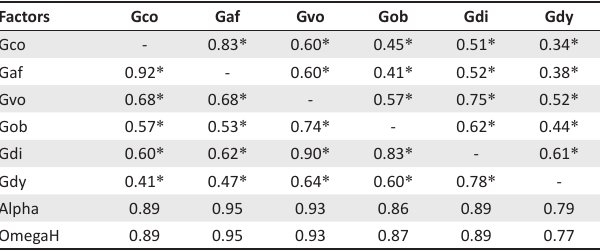
TABLE 2: Correlations and covariances of goal commitment